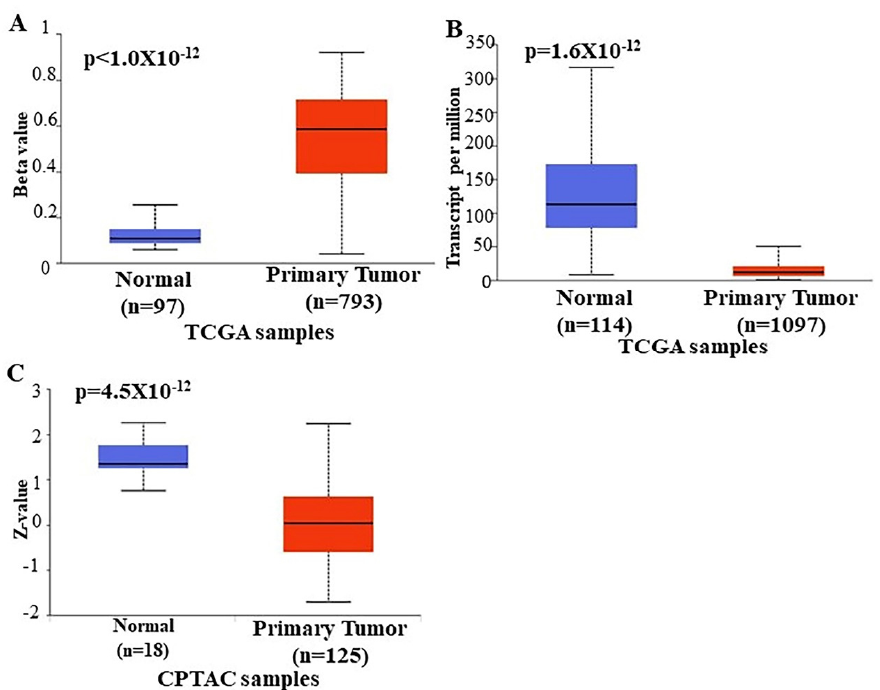
Figure 3. Analysis of ENPP2 ( A ) promoter DNA methylation, ( B ) mRNA expression, and ( C ) ATX protein expression between primary BrCa tumors and normal tissues using the UALCAN platform. Abbreviations: TCGA: The Cancer Genome Atlas, CPTAC: Clinical Proteomic Tumor Analysis Consortium, BrCa: breast